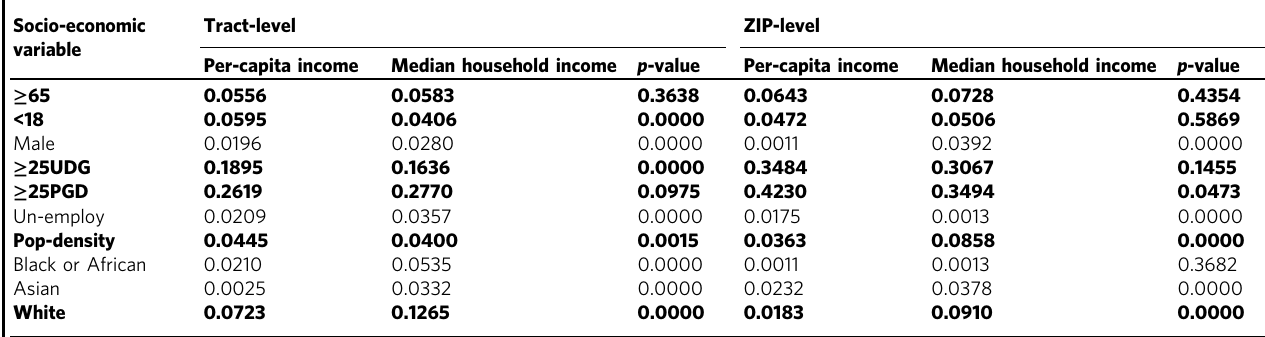
Table 5 Average absolute SHAP values of individual socio-economic variables.